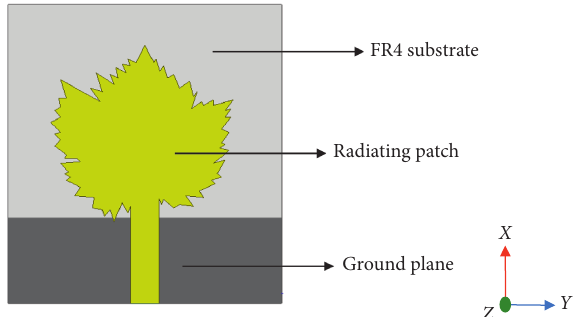
Figure 3: Proposed compact bioinspired UWB antenna.